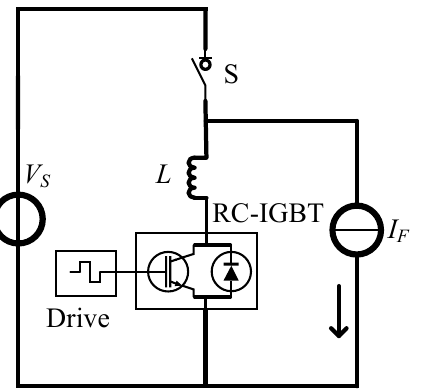
Figure 5. Inductive load test circuit for turn-off behavior of built-in diode.